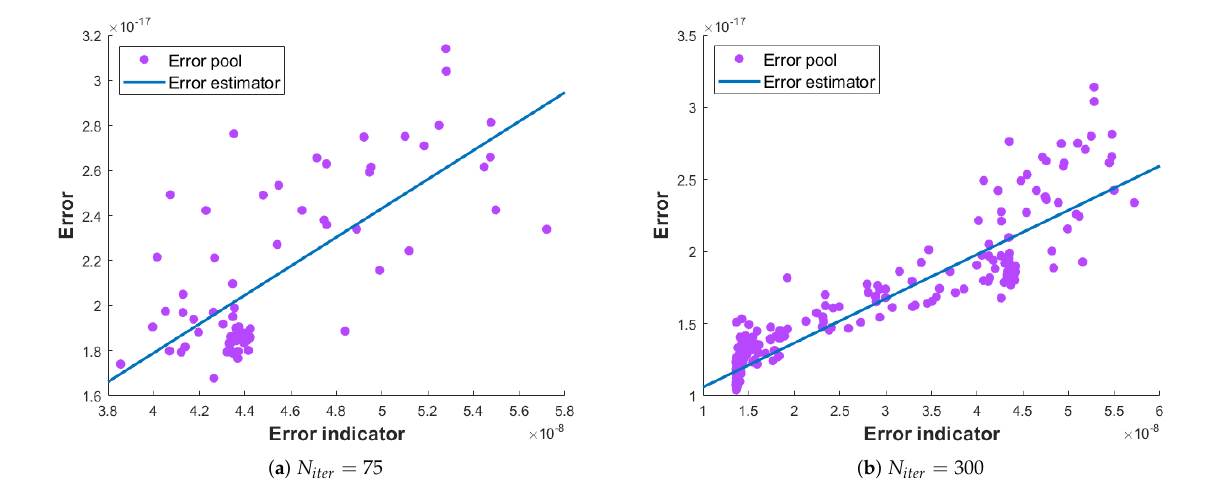
Figure 7. The error estimator after ( a ) N iter = 75 and ( b ) N iter = 300 iterations constructed using the error pool set η .